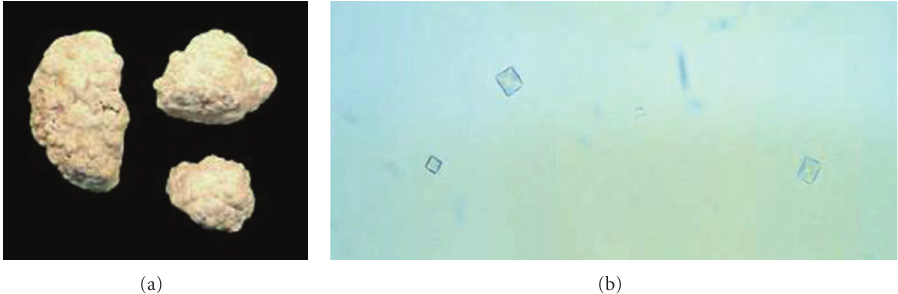
Figure 4: Calcium oxalate stones (a) and urine microscopic examination showing calcium oxalate monohydrate crystals (b) in